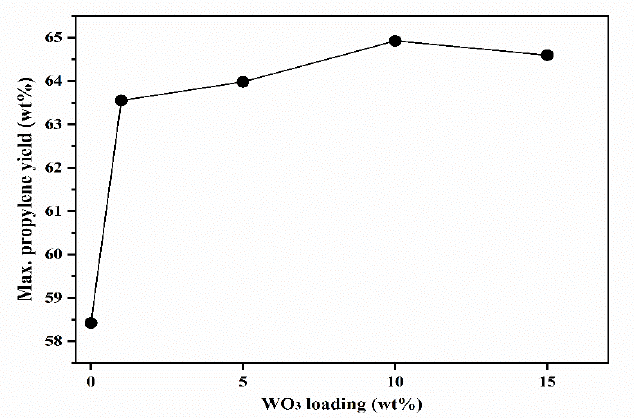
Figure 3. The relationship between WO 3 loading and ETP reactivity.